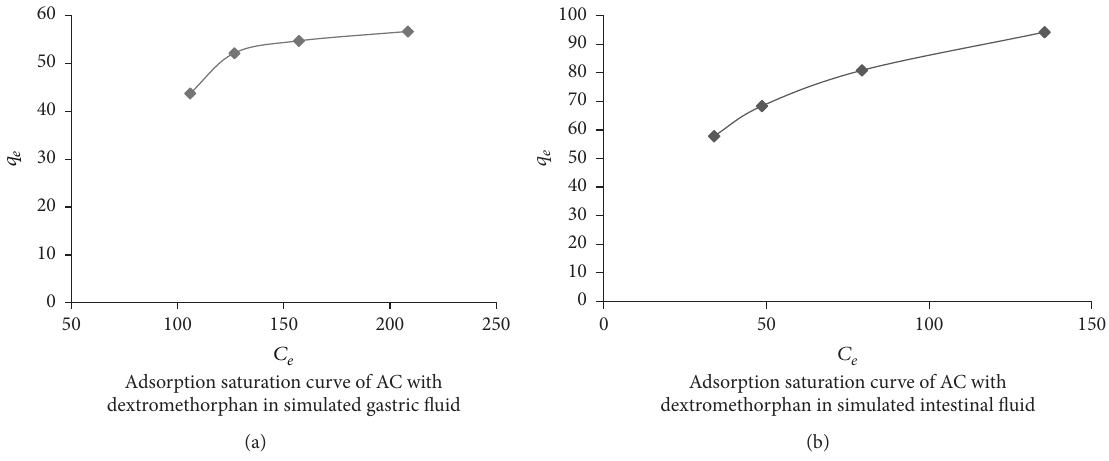
Figure 1: Adsorption saturation curve of AC with DXM in (a) simulated gastric fluid and (b) simulated intestinal fluid.